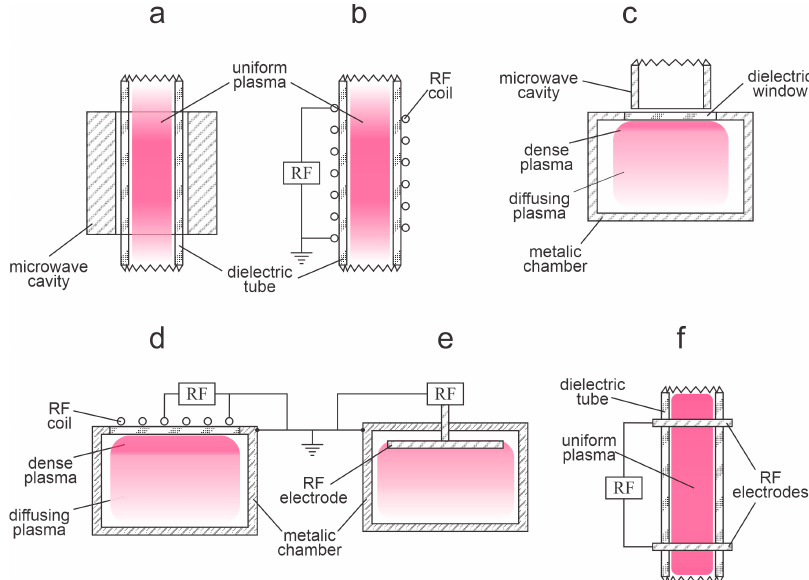
Figure 2. Examples of low-pressure high-frequency discharges. ( a ) Microwave in a dielectric tube, ( b ) inductive cylindrical RF in H-mode, ( c ) microwave in a metallic chamber, ( d ) inductive RF in a metallic chamber, ( e ) classical capacitive RF, and ( f ) electrodeless capacitive RF.